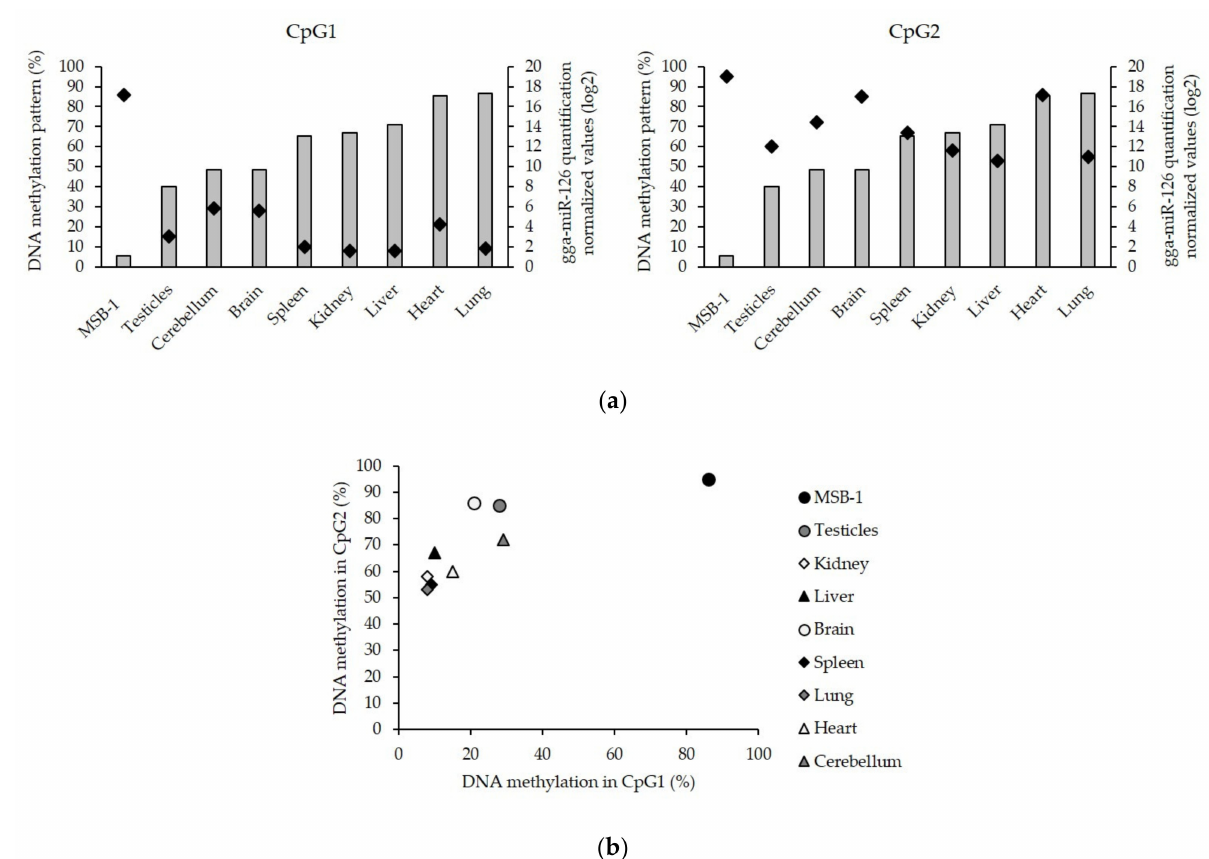
Figure 5. Comparison of the DNA methylation pattern in the CpG1 and CpG2 regions of EGFL-7 . ( a ) Correlation between the miR-126 quantification (right Y-axis, gray histograms) and the DNA methylation percentage (left Y-axis, black diamond) in the CpG1 and CpG2 regions of different samples used (MSB-1 cell line and the eight organs from three uninfected chicken). ( b ) Comparison of the DNA methylation percentage in the CpG1 region (X-axis) and CpG2 region